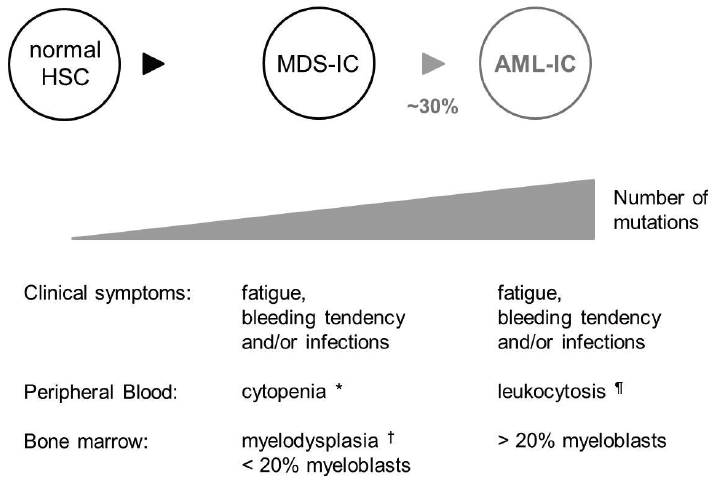
Figure 1. Characteristic features of myelodysplastic syndrome (MDS) in humans. MDS is thought to originate from a mutated Hematopoietic stem cell (HSC). Approximately 30% of MDS patients progress to AML (acute myeloid leukemia) [30]. With each stage, an increased number of mutations in essential genes can be observed [24,31]; the classic representation of both diseases is depicted. Although MDS and AML have very similar clinical symptoms, they can be distinguished from each other by cell counts in the peripheral blood and pathological review of the bone marrow. Classical MDS is associated with myelodysplasia in the bone marrow and cytopenia in one or more myeloid lineages in the peripheral blood. However, a level of >20% myeloblasts in the bone marrow is indicative for AML and excludes the diagnosis of MDS [39,40]. Signs of myelodysplasia can still be present in bone marrow samples of MDS patients that have progressed to AML. In some patients, myelodysplasia and <20% myeloblasts in the bone marrow is accompanied with cytosis in one of the peripheral blood lineages; these patients are diagnosed with MDS/MPN (myleoproliferative neoplasm) overlap disease, which is a different disease altogether [41]. MDS-IC, MDS initiating cell; AML-IC, AML initiating cell; * Cytopenia, significantly fewer cells than normal in one of the peripheral blood lineages; ¶ Leukocytosis, significantly more leukocytes than normal in the peripheral blood; † Myelodysplasia, abnormal blood cell